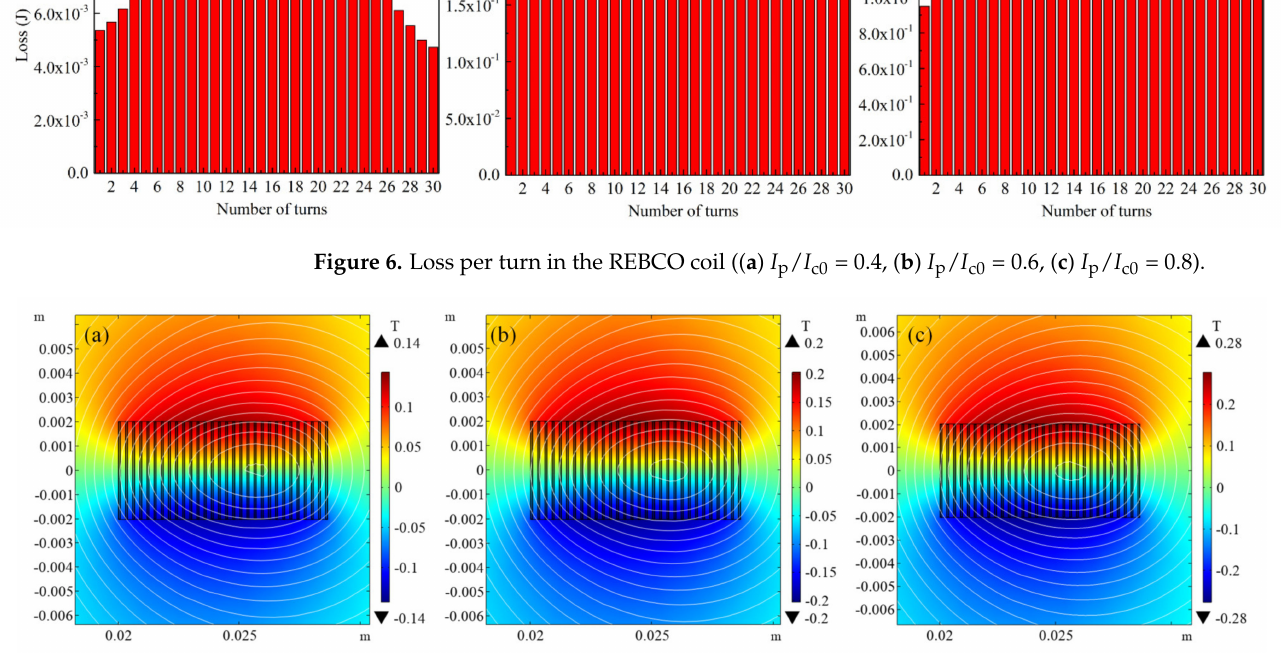
Figure 7. Magnetic force lines and radial flux density distributions in the REBCO coil when t = 0.01 s